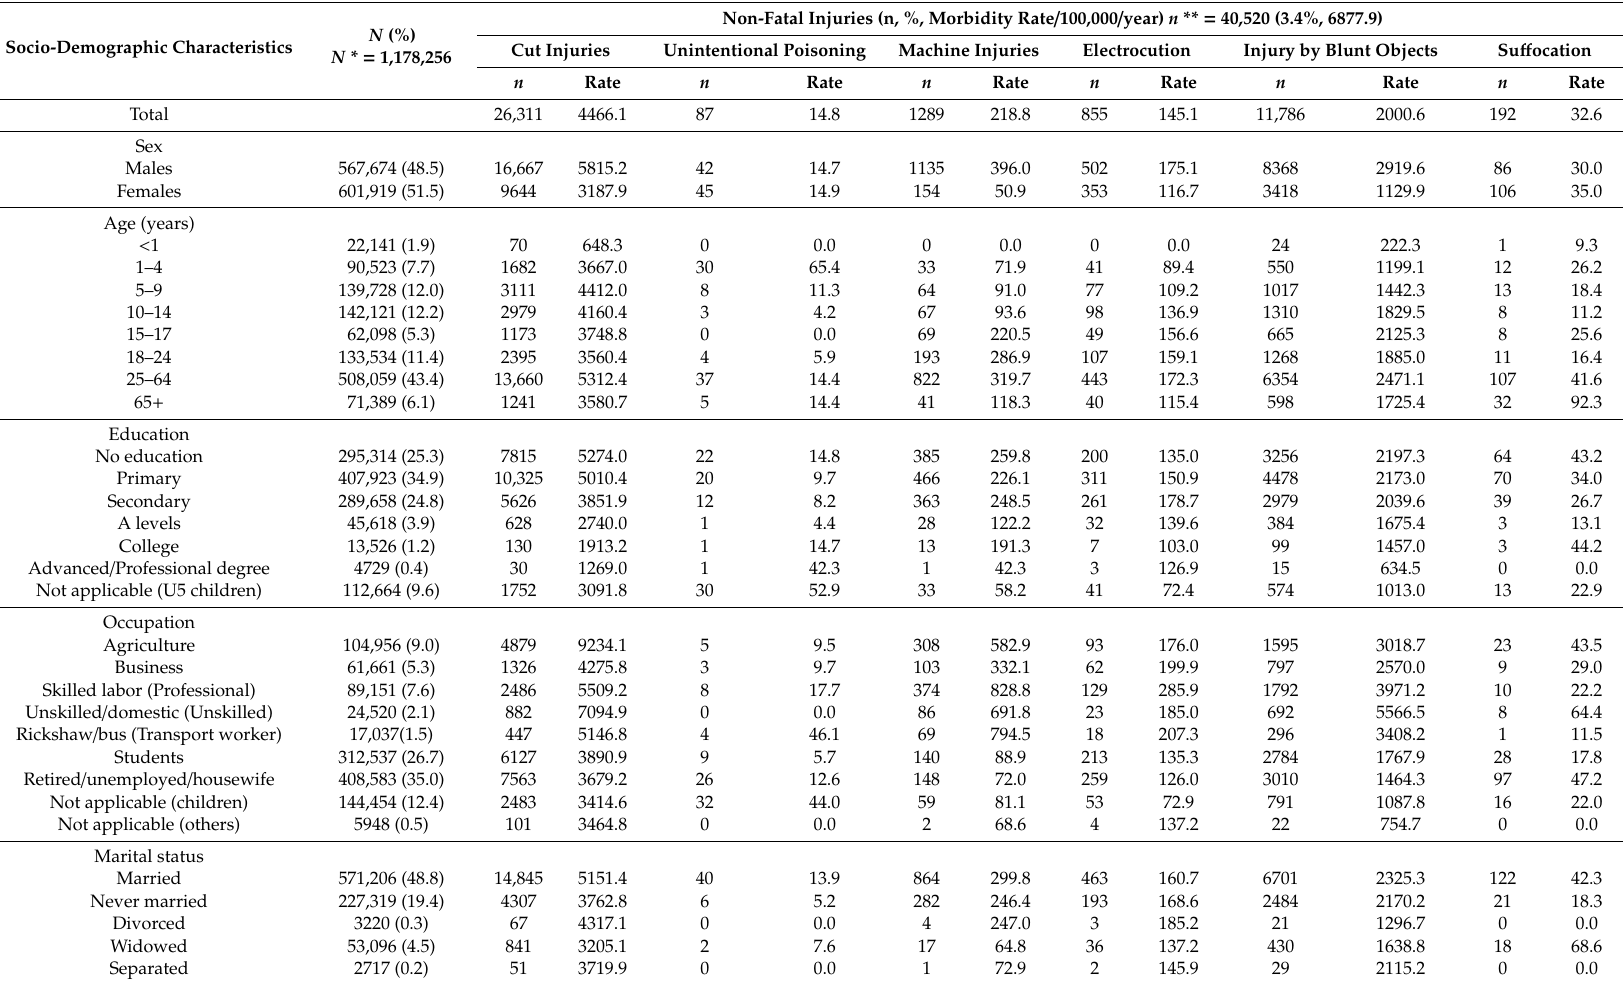
Table 1. Socio-demographic characteristics of the study population for di ff erent injuries in rural Bangladesh. Socio-Demographic